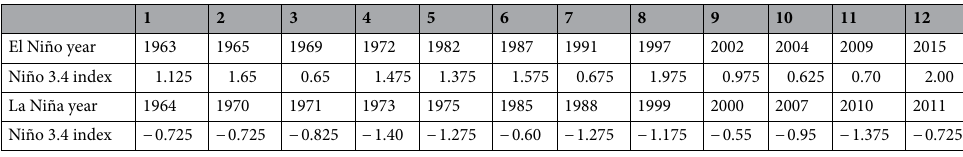
Table 1. El Niño Years and La Niña Years from 1961 to